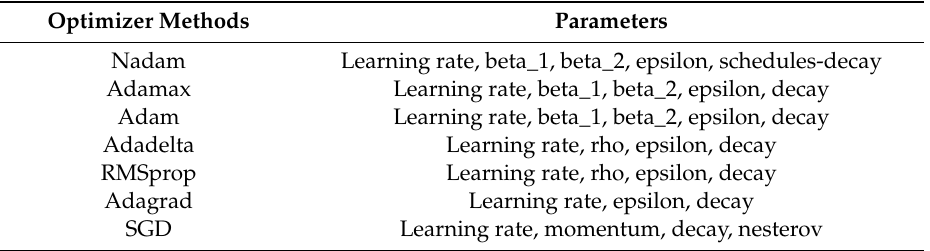
Table 7. Parameters of each optimizer